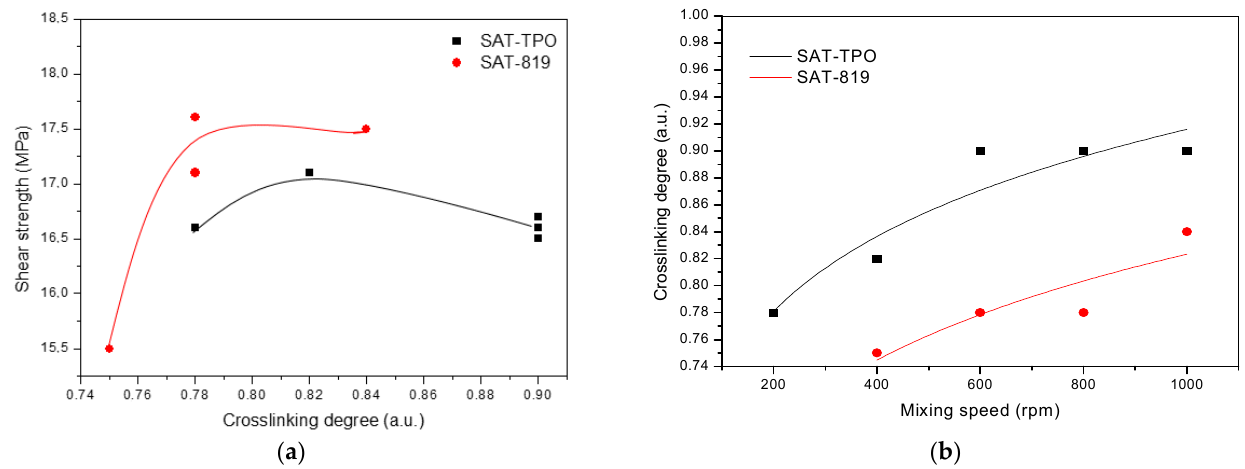
Figure 6. The influence of ( a ) the crosslinking degree of thermally cured SATs on overlap shear strength of Al/SAT/Al joints and ( b ) mixing speed on the crosslinking degree.